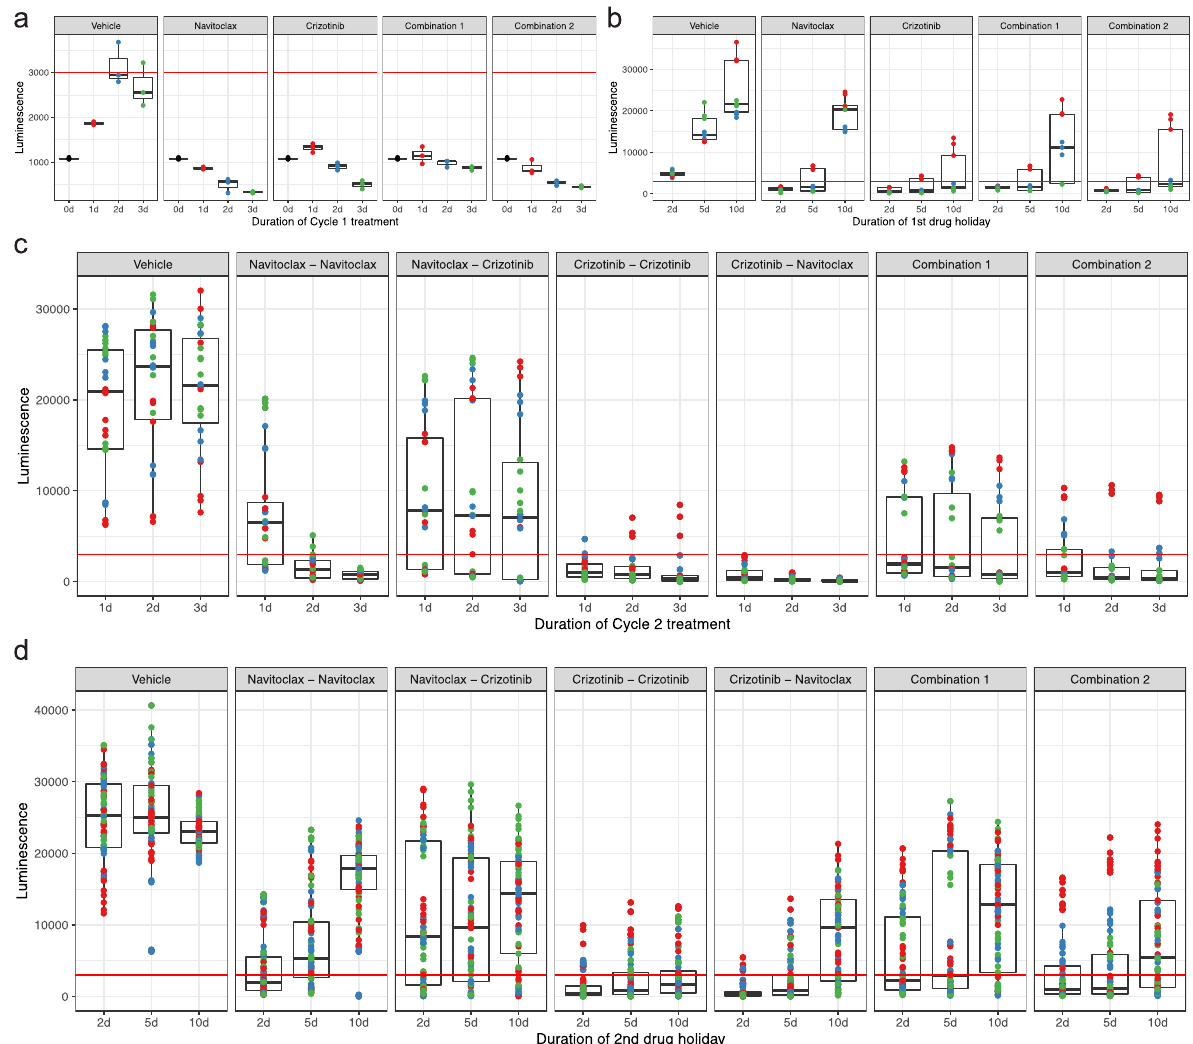
Fig. 4 Effect of treatment schedules on cell response. a Effect of cycle 1 treatment and duration on MDA-MB-231 cell growth. b Effect of the duration of drug-free recovery after cycle 1. Each group corresponds to a different duration of drug-free recovery and includes all cycle 1 schedules for the corresponding treatment regimen. c Effect of cycle 2 treatment and duration over all the combinations of cycle 1 treatment durations and drug-free recovery periods. d Effect of the duration of recovery after cycle 2, over all the other combinations of prior durations. Combination 1 included equal doses of navitoclax and crizotinib. Combination 2 included a higher dose of crizotinib than navitoclax. Throughout the plots, points have been color-coded based on the duration of cycle 1 treatment (vehicle — black, 1 day —